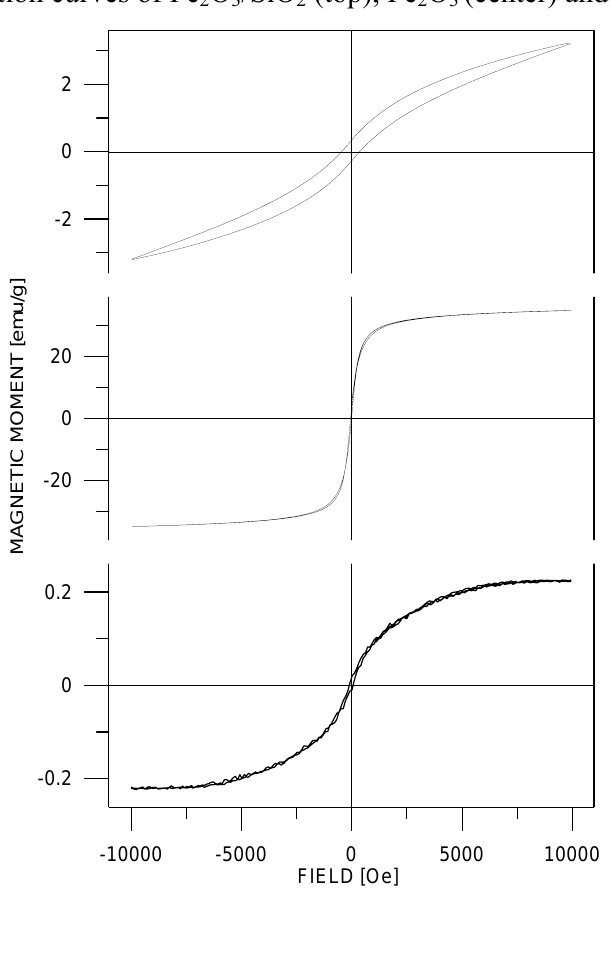
Figure 6. Magnetization curves of Fe